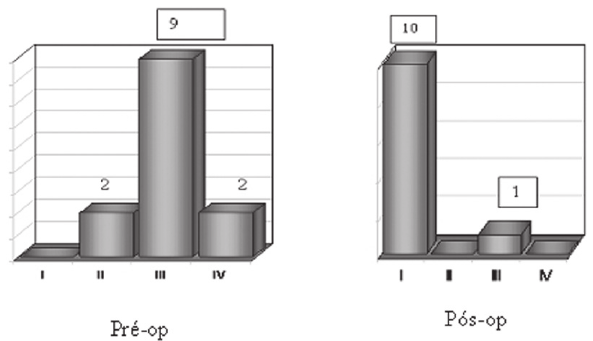
Fig. 2 - Classe funcional pré e pós-operatória (NYHA)